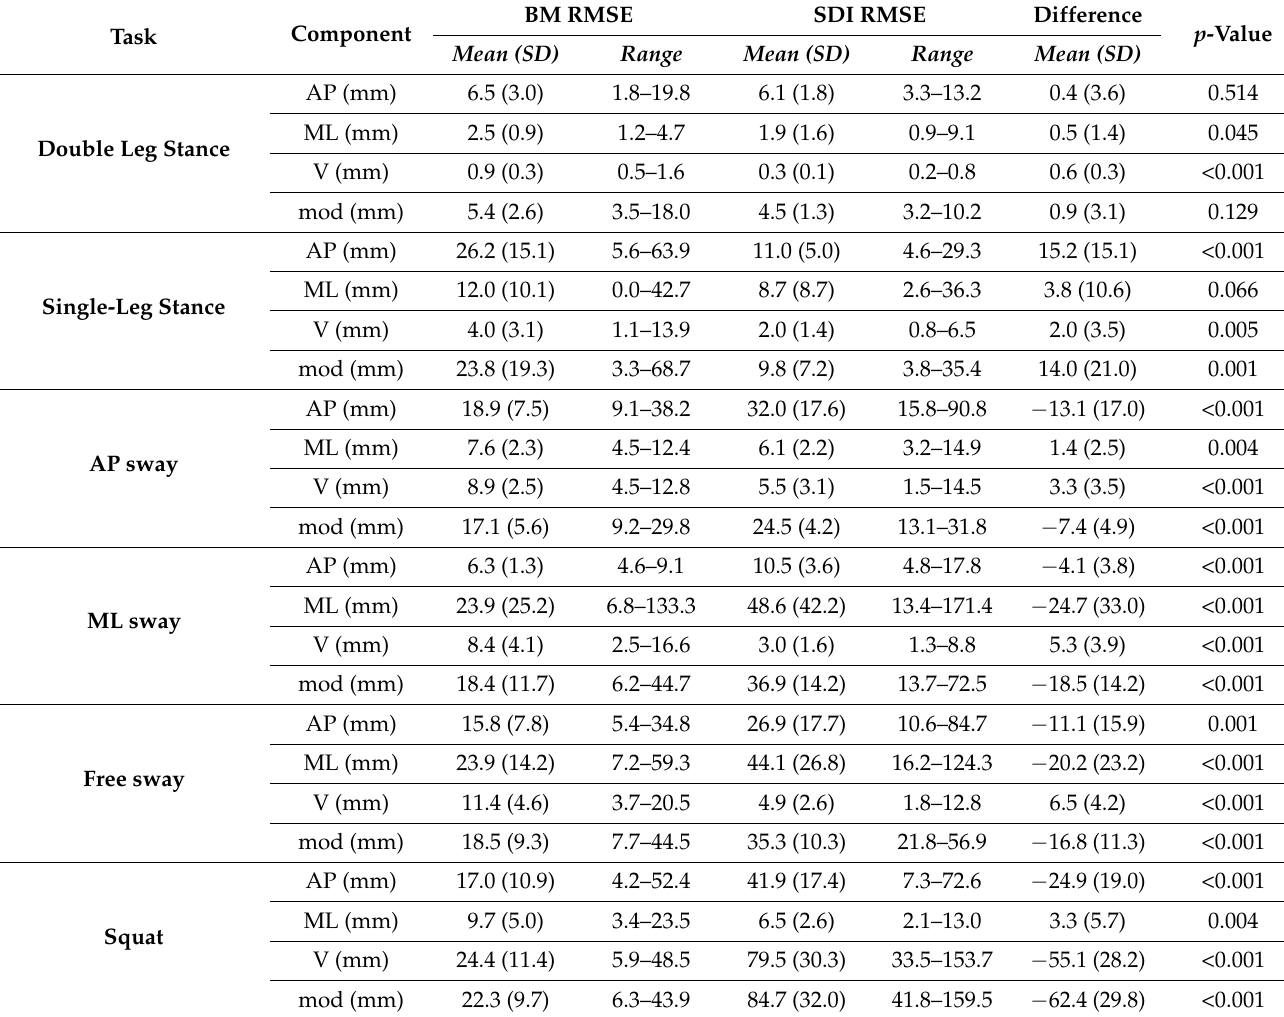
Table 1. Root mean square errors (RMSEs) of the two methods based on MIMUs (Biomechanical Model, BM and Strapdown Integration, SDI), calculated using the optoelectronic system as the reference method, for the six considered tasks. RMSEs are computed for each component of the CoM—anteroposterior (AP), mediolateral (ML), and vertical (V), as well as separately for the modulus (mod). Negative RMSE differences refer to lower RMSEs in the BM; positive RMSE differences cells refer to lower RMSEs in the SDI. P values refer to the paired t -tests.